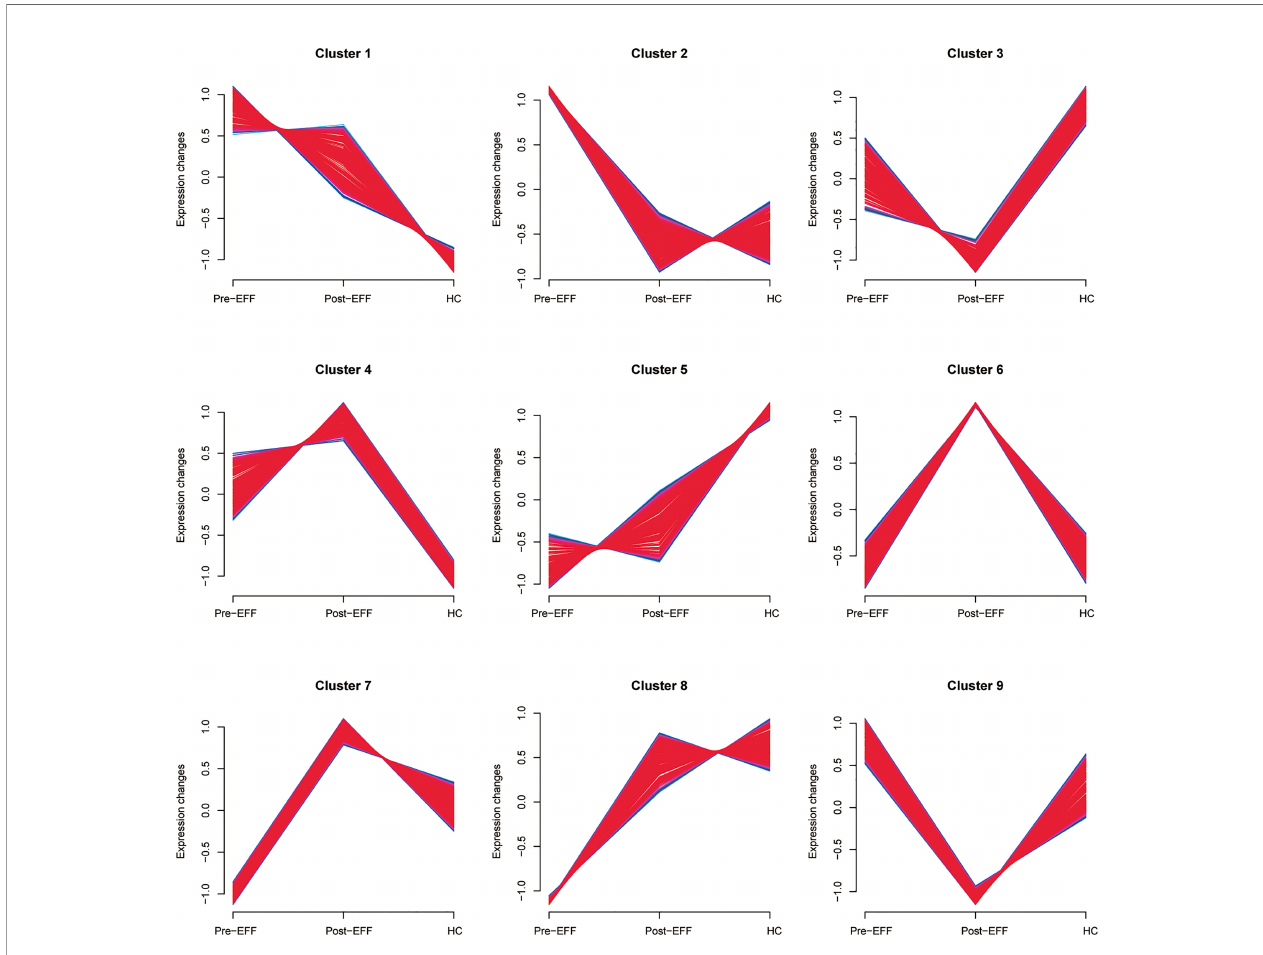
FIGURE 7 | Nine protein clusters correlated with IC bene fi ts identi fi ed by soft cluster analysis. The horizontal axis represents groups and the vertical axis represents expression changes in proteins around the time of IC in the EFF cohort. Protein expression changes in cluster 1 and cluster 2 show a high positive correlation with IC bene fi ts, and protein expression changes in cluster 7 and cluster 8 showed a low positive correlation with IC bene fi